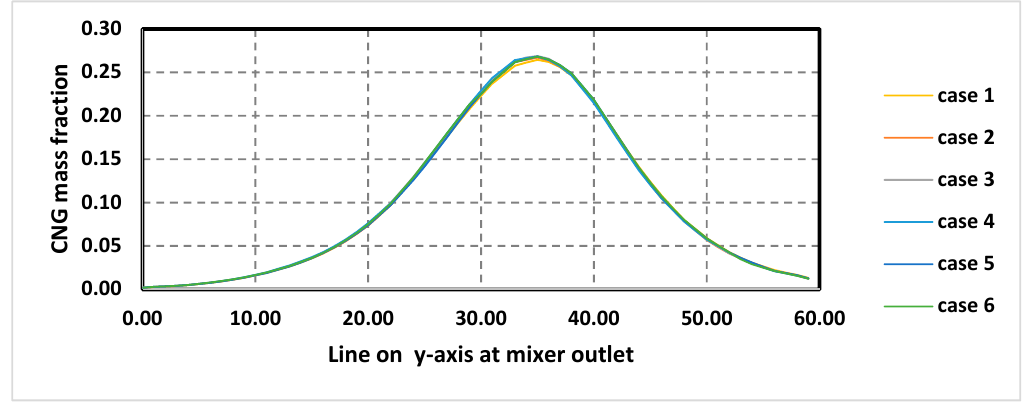
Figure 8. CNG mass fraction on line in y -axis at mixer outlet (model 1), grid independence test results.